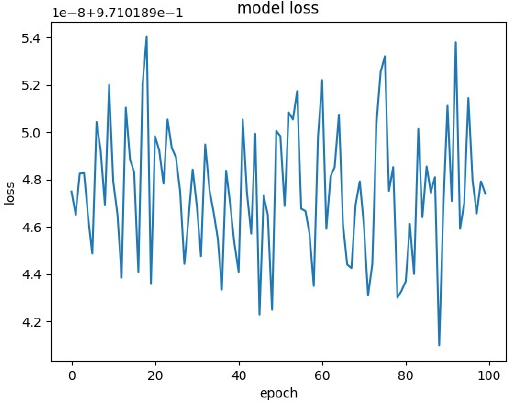
Figure 1. Loss plot for model with 3000 samples, 500 epochs, one-hot encoding of IUPAC international chemical identifiers (InChIs).